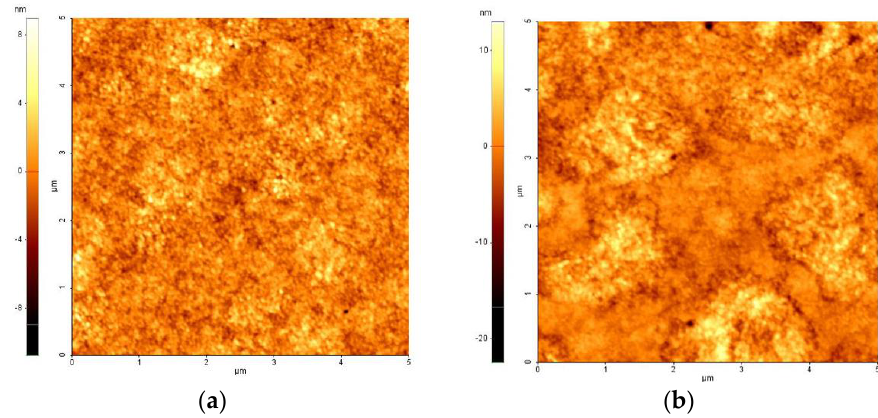
Figure 3. Atomic force microscopy (AFM) images of ZnO layer on patterned ITO glass with ( a ) one-step spin-coating process (1SC, roughness root mean square (R rms ) = 1.398 nm) and ( b ) two-step spin-coating process (2SC, R rms = 2.645 nm).